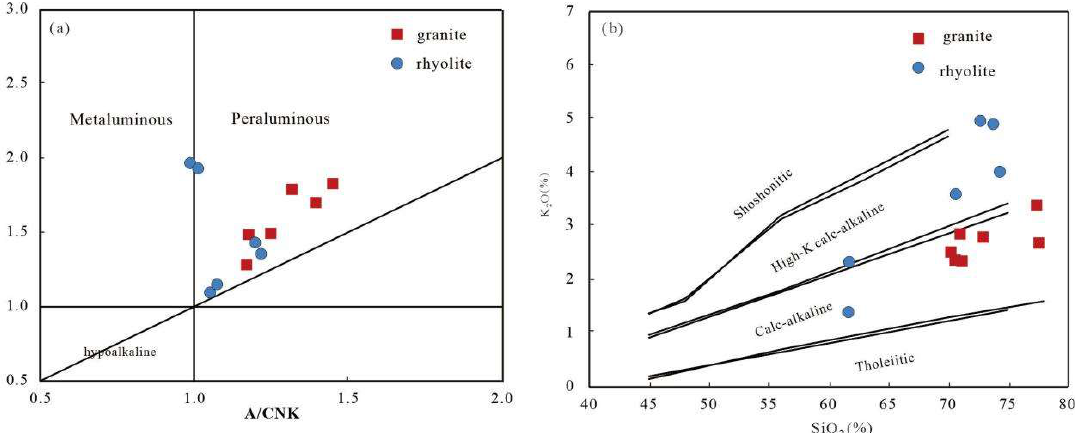
Figure 4. ( a ) A/NK vs. A/CNK, diagrams of the Early Cretaceous magmatic rock from the Badaguan area, modified from Maniar and Piccoli. [29] and ( b ) SiO 2 vs. K 2 O diagrams of the Early Cretaceous magmatic rock from the Badaguan area, modified from Peccerllo and Taylor [30].